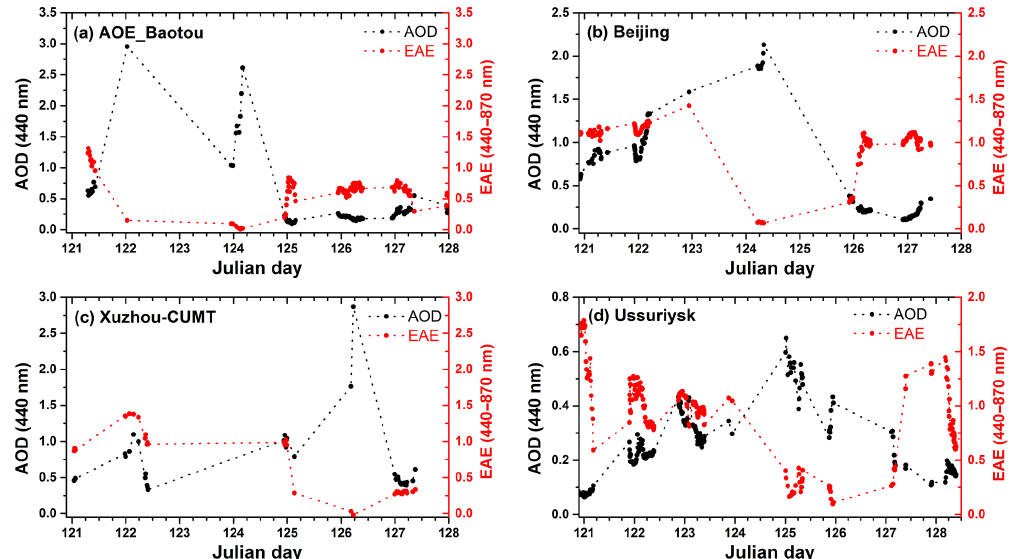
Figure 13. Variations in the AOD (440nm) and Ångström exponent (440–870nm) at (a) AOE_Baotou, (b) Beijing, (c) Xuzhou-CUMT, and (d) Ussuriysk during 1–8 May 2017.